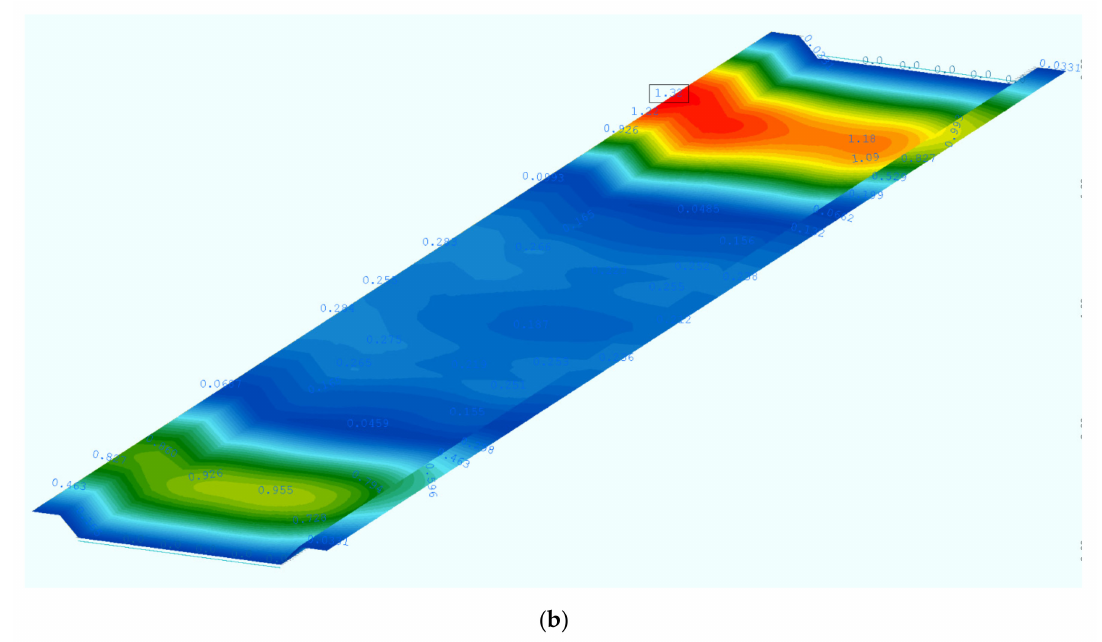
Figure A7. Extreme displacement f (mm) under the SLS combination of traffic loadings class C according to PN-S-10030 [56] standard: ( a ) 3 D structure view; ( b ) displacement map on the deck